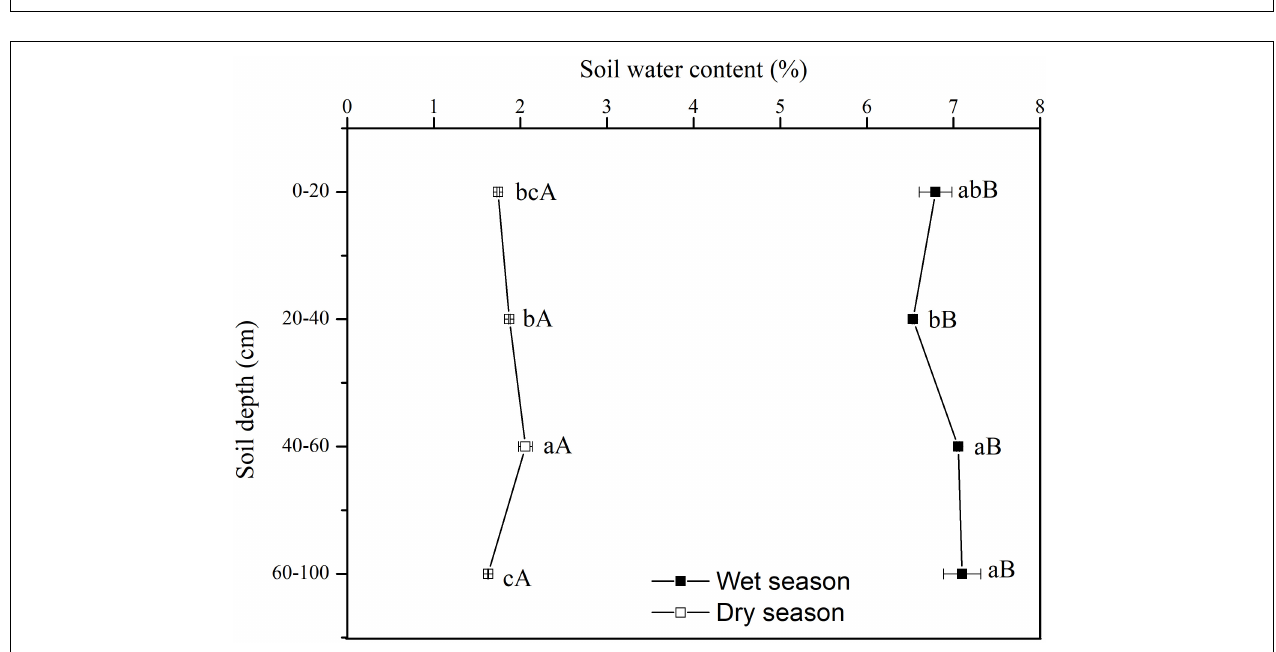
FIGURE 2 | Monthly precipitations for 2013 and 2014 on Chenier Island, Yellow River Delta, China.